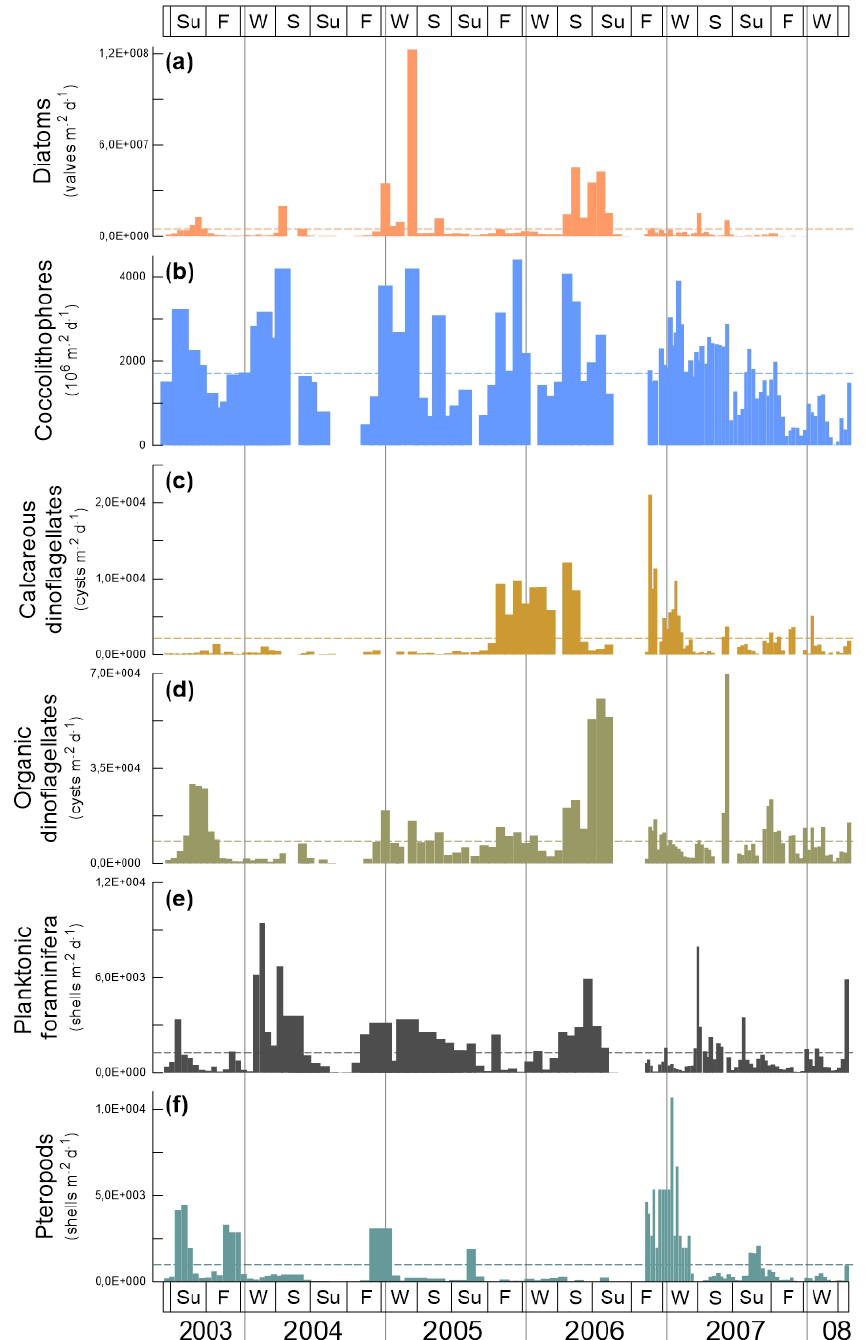
Figure 3. Fluxes of microorganisms at the trap site CBeu between June 2003 and March 2008. From top to bottom: (a) diatoms (valvesm − 2 d − 1 , peach bars; note that 10 samples corresponding to CBeu 5 – 13 December 2007 through 17 March 2008 – were not avail- able for diatom analysis); (b) coccolithophores (coccolithsm − 2 d − 1 , light blue bars); (c) calcareous dinoflagellates (cystsm − 2 d − 1 ; gold bars); (d) organic dinoflagellates (cystsm − 2 d − 1 ; khaki bars); (e) planktonic foraminifera (shellsm − 2 d − 1 ; gray bars), and (f) pteropods (shellsm − 2 d − 1 ; ocean green bars). The horizontal stripped line for each group of organisms represents the average flux for the whole study interval. The boxes in the upper and lower panels represent seasons (Su: summer, F: fall, W: winter, S: spring). The vertical background gray lines indicate calendar year separation. For interpretation of the references to color in this figure legend, the reader is referred to the web version of this